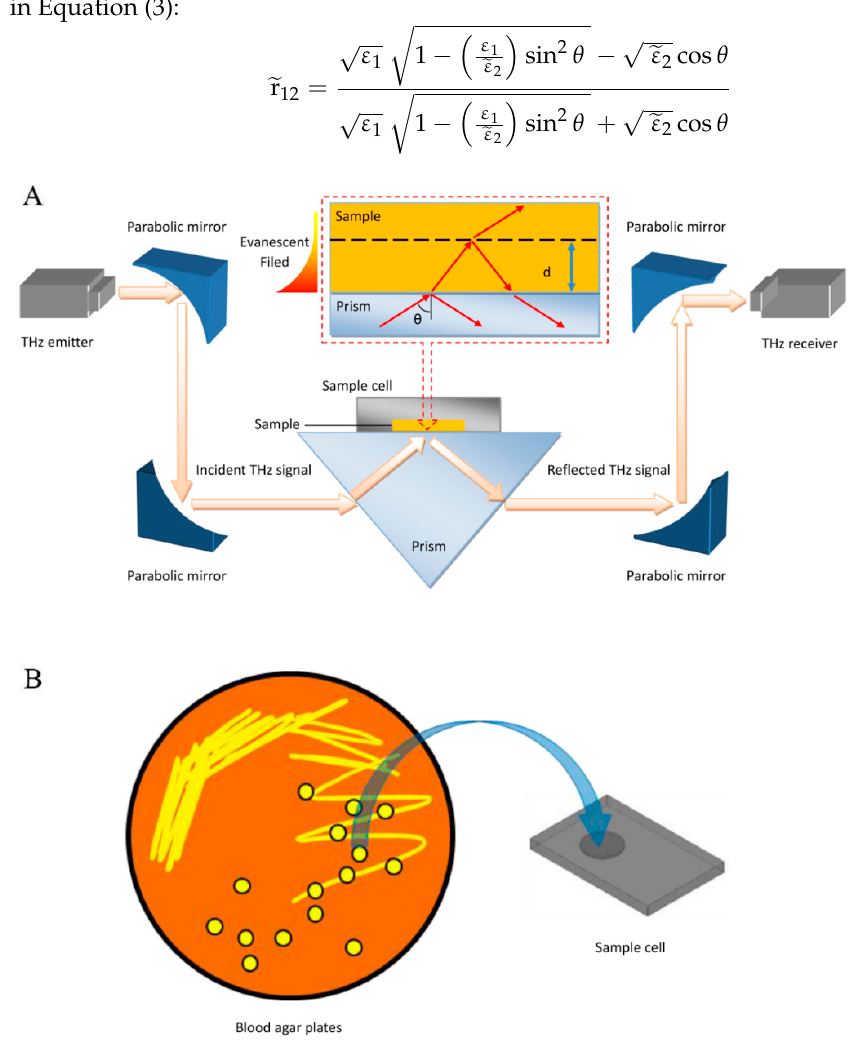
Figure 1. Identification of clinical microbes based on their THz-ATR spectra. ( A ) Schematic illustration of the THz-ATR spectrometer with a sample cell made of Si. (Inset) Diagram of the THz-ATR spectrometer with a “prism–sample” model. ( B ) Schematic showing sample loading.